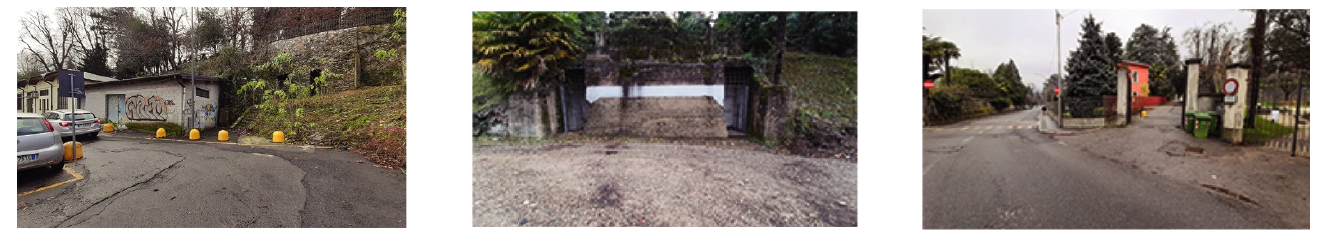
Figure 5. Views of the various entrances to the bunker. Photos by A. Pilo.